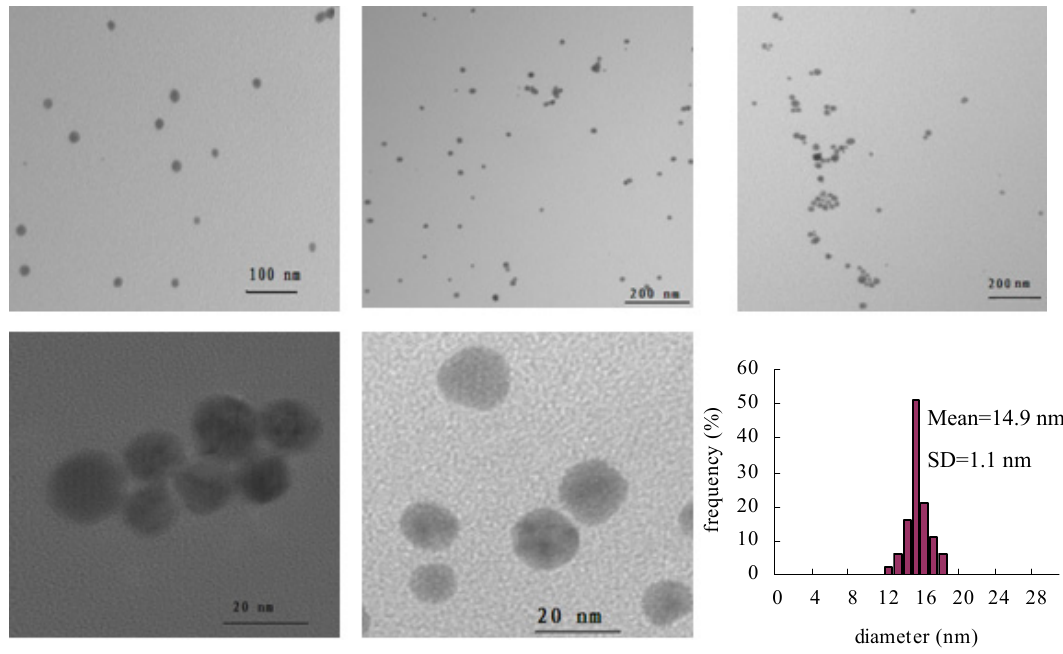
Figure 8. TEM images and size distribution of gold nanoparticles. The first five figures show TEM images of gold nanoparticles at different view areas and their size